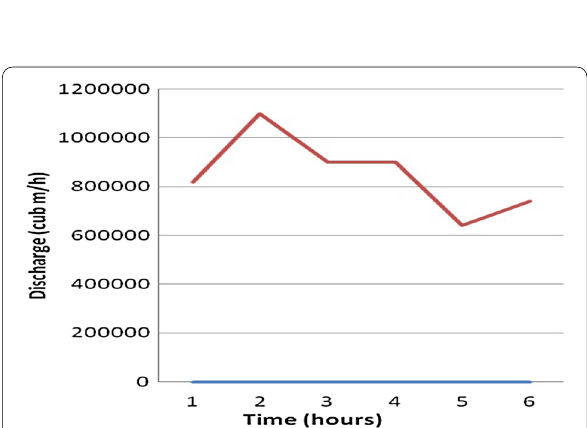
Fig. 8 The estimated hydrograph for the flash flood event of October 2019 in Wadi